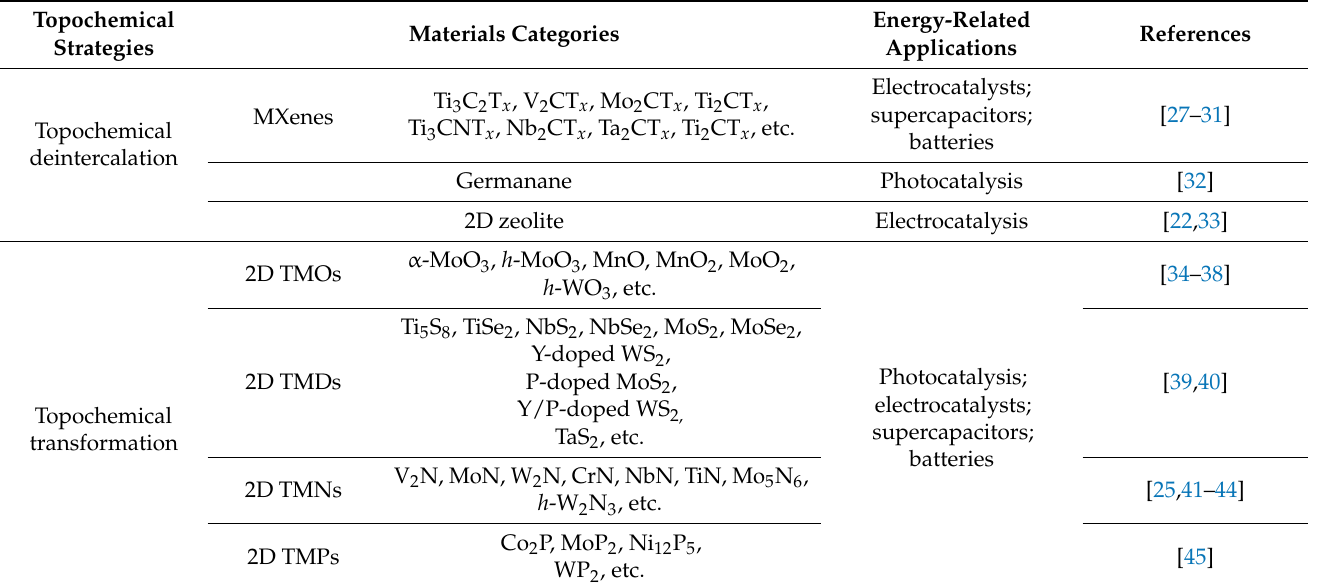
Table 1. A summary of 2D materials produced by topochemical strategies and their application introduced in energy-related field of this